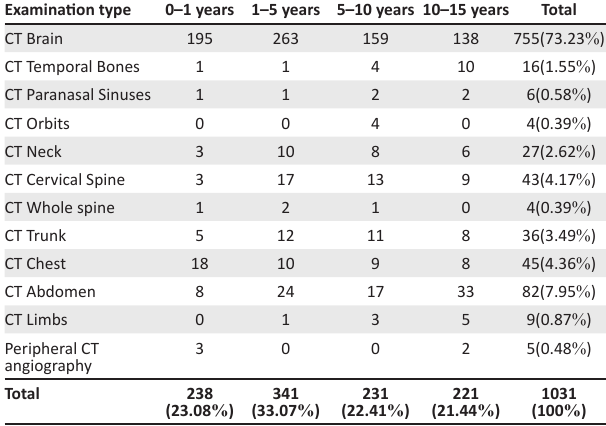
TABLE 1: Total number of scans included in the study per computed tomography examination type for each age category ( n = 1031). Examination